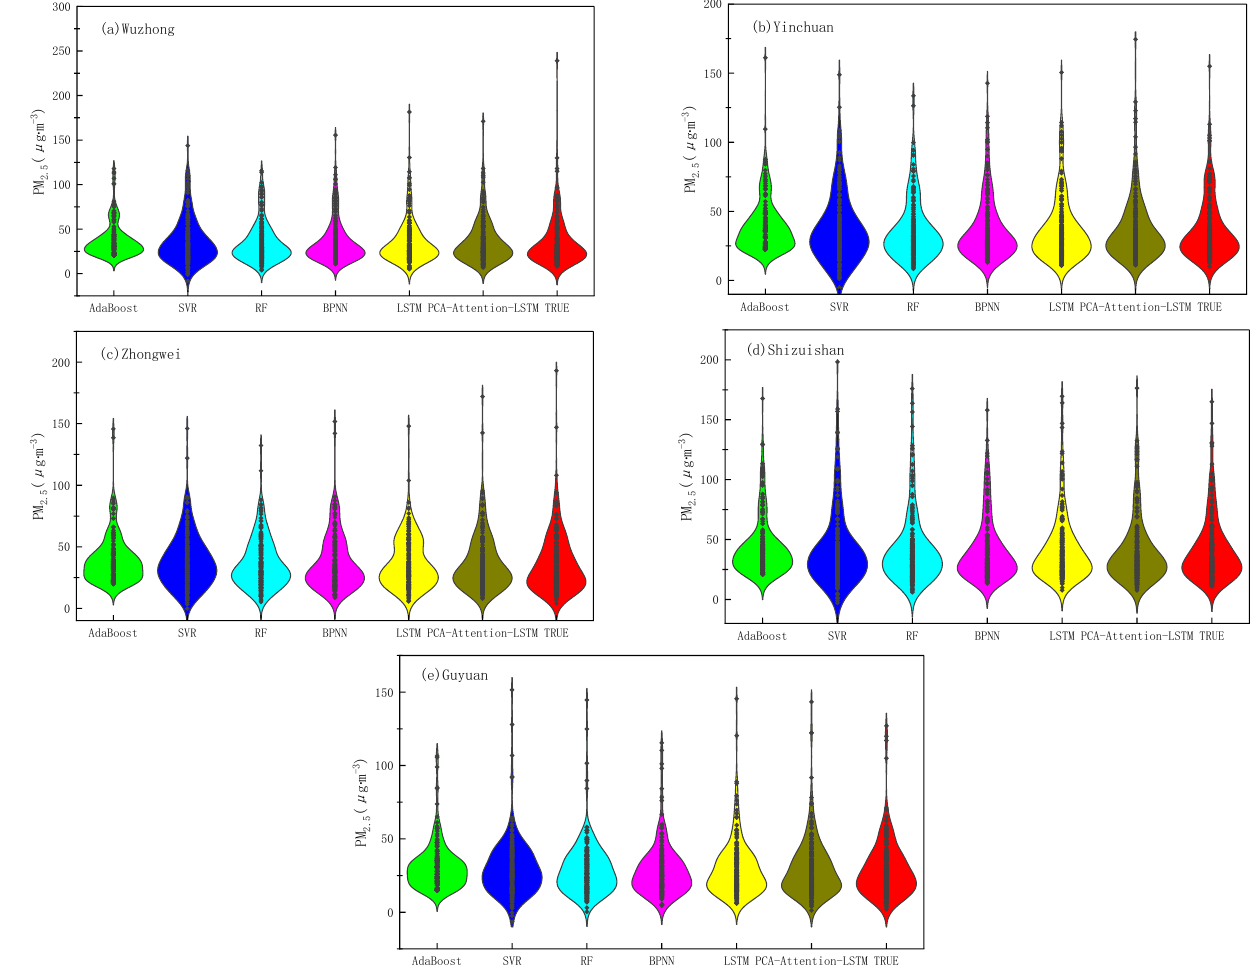
Figure 9. A plot of the distribution of predicted and true values. ( a ) Wuzhong; ( b ) Yinchuan; ( c ) Zhongwei; ( d ) Shizuishan; ( e ) Guyuan.